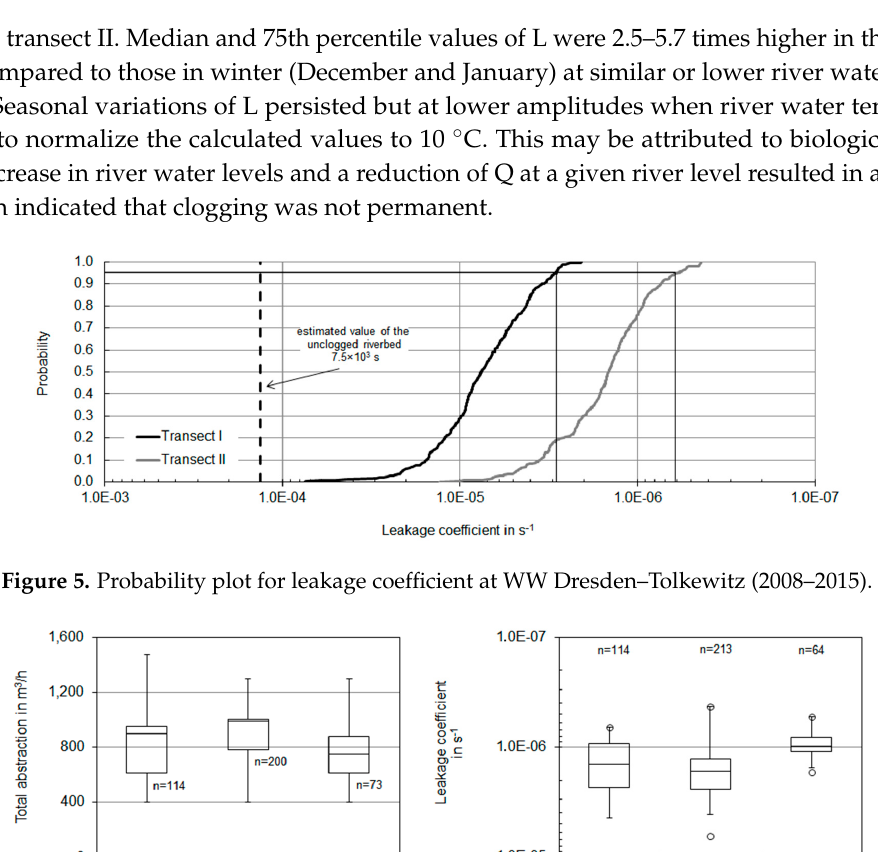
Table 2. Mean values for L in 10 − 6 s − 1 at riverbank filtration sites along the upper Elbe River, 1991–1993 [14].